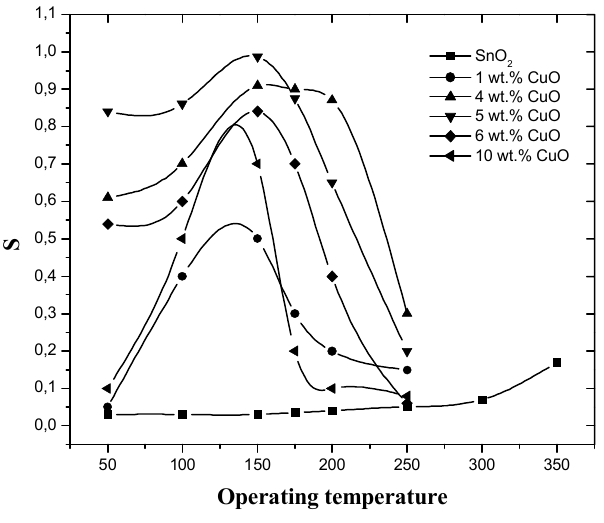
Figure 4. Gas sensitivity of pure and CuO-doped SnO temperatures.